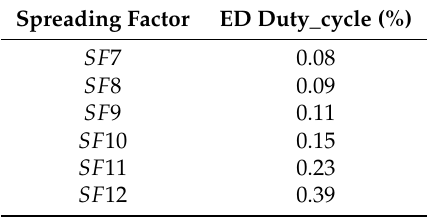
Table 6. Duty_cycle(ED) for a monitoring period of 400 s and a synchronization period of 1602